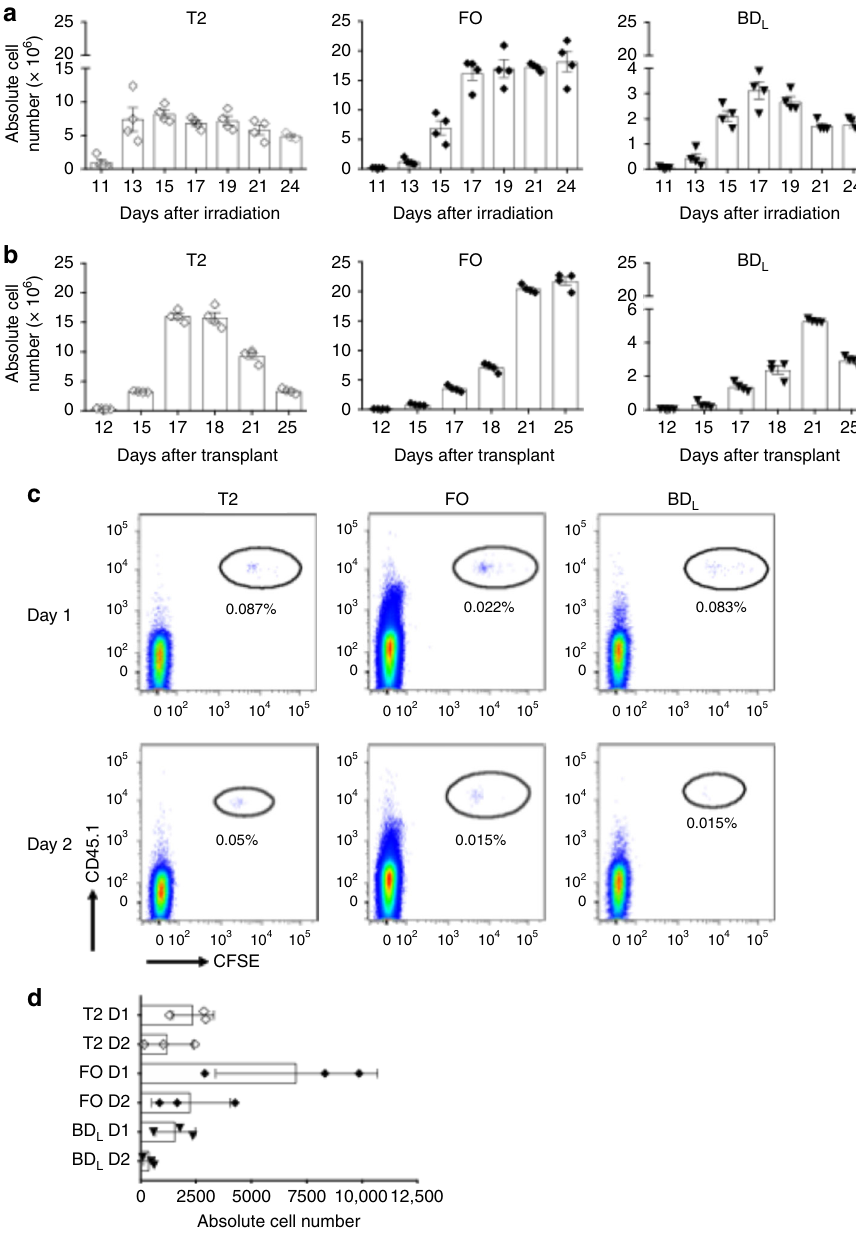
Fig. 6 BD L are mature and emerge from the T2 stage. a C57BL/6J mice were sublethally irradiated (500 rad) and the emergence of T2, FO, and BD L was tracked in the spleen on the days indicated by fl ow cytometry and the absolute number of cells was calculated. b C57BL/6J mice were lethally irradiated (950 rad) and transplanted with syngeneic BM and the emergence of T2, FO, and BD L was tracked in the spleen on the days indicated by fl ow cytometry and the absolute number of cells was calculated. a , b Individual data points (mice) are shown superimposed upon the mean ± SEM. c , d C57BL/6J CD45.1 mice were sublethally irradiated (500 rad) and 15 days later T2 cells were FACS puri fi ed, labeled with CFSE, and 1.25 × 10 6 cells/recipient were adoptively transferred to C57BL/6J CD45.2 mice and 24 and 48 h later the percentage ( c ) and absolute number ( d ) of T2, FO, and BD L was determined in the spleen by fl ow cytometry. T2, FO, and BD L B cell subsets were gated as for Fig. 2a, b. c Data shown are one representative experiment of three. d Individual data points (mice) are shown superimposed upon the mean ± SEM from one representative experiment of three. Statistical signi fi cance was determined